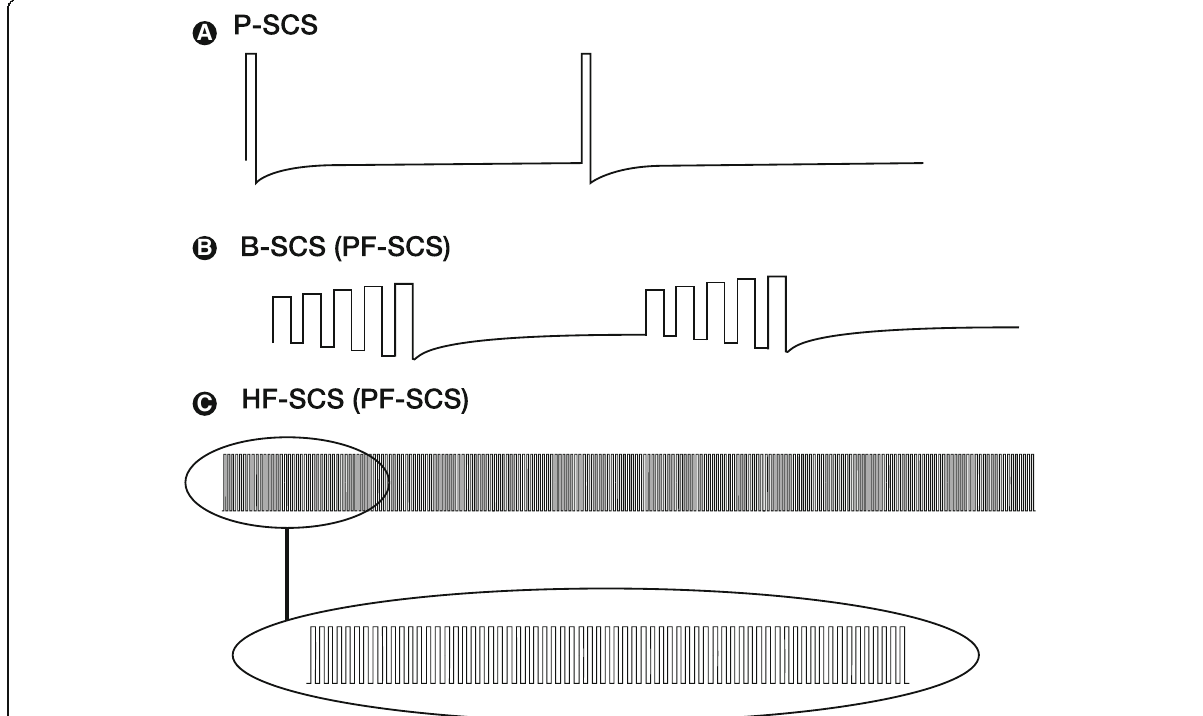
Fig. 10 Stimulation Patterns in Paresthesia and Paresthesia Free SCS Paradigms: Traditional SCS comprised of tonic or repetitive low frequency SCS usually in the range of 40 – 60 Hz produces paresthesia of P-SCS ( a ). Paresthesia free, burst spinal cord stimulation (B-SCS) employs incremental increase in amplitude with each burst. Inter-burst frequency is 40 Hz, while intra-burst frequency is 500 Hz ( b ). Between each burst there is a passive recharge phase. Paresthesia free high frequency SCS employs an ultra-high frequency of 10 kHz in continuous mode ( c